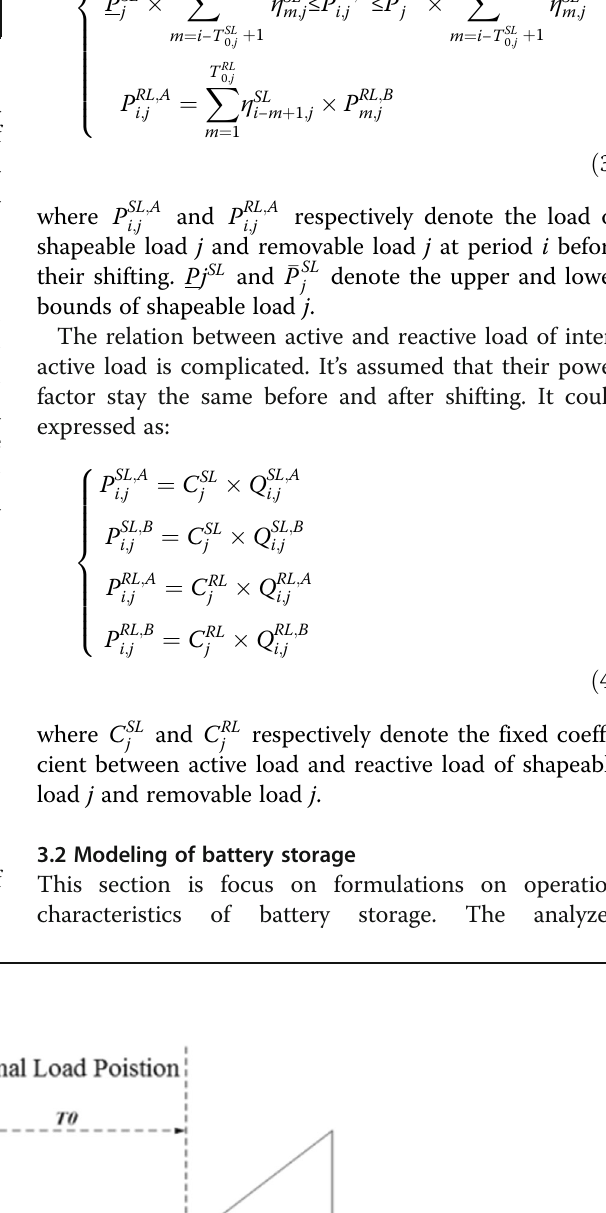
Fig. 5 The Structure of Battery Storage (should be Fig. 5, it ’ s changed